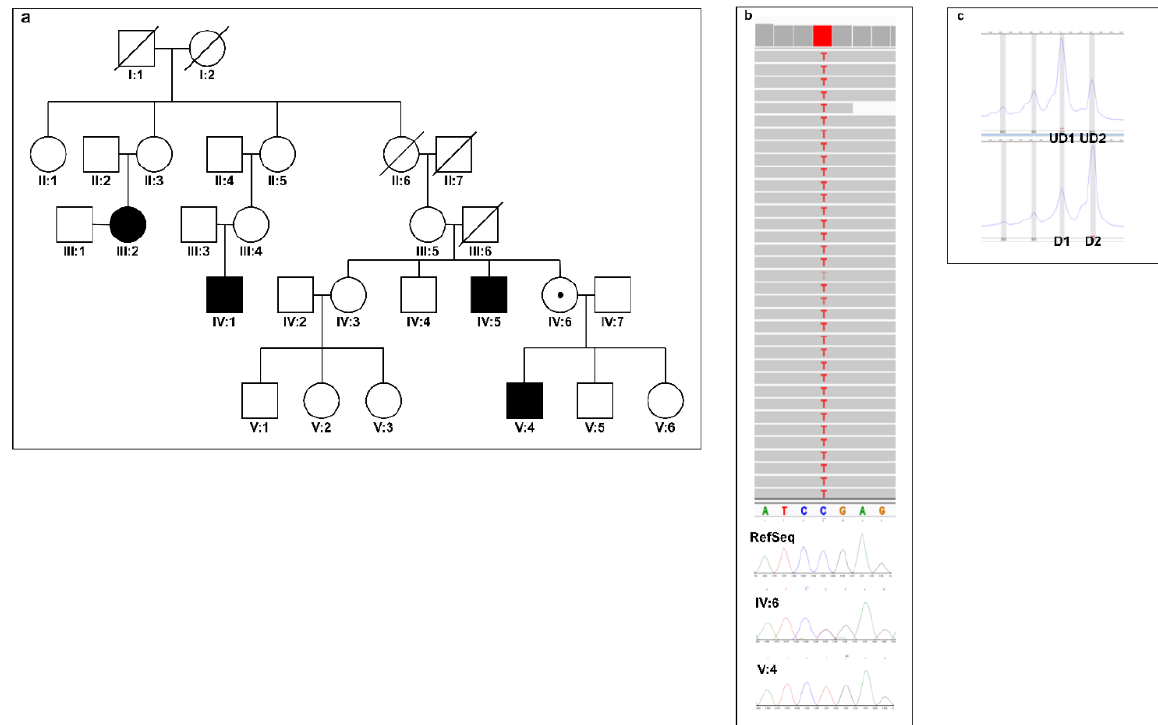
Figure 1. ( a ) Pedigree of the family; ( b ) Visualization of the X-chromosome exome sequencing results in the Integrative Genomics Viewer (IGV). Below are the Sanger sequencing results. The sequencing confirmed the hemizygous variant c.757C>T in the proband (IV:2) and heterozygous variant in the mother (III:2); ( c ) The result of the chromosome skewing is calculated as (D1/UD1)/(D1/UD1 + D2/UD2) when D1 and D2 represent the value of an area under the digested first, second peaks; UD1 and UD2 correspond to the area under undigested peak one and two.